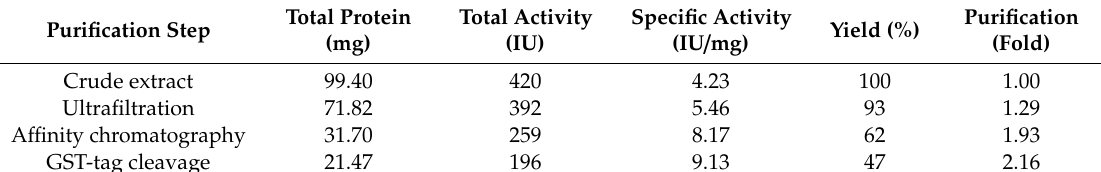
Table 10. S. griseus recombinant β -glucosidase purification table.